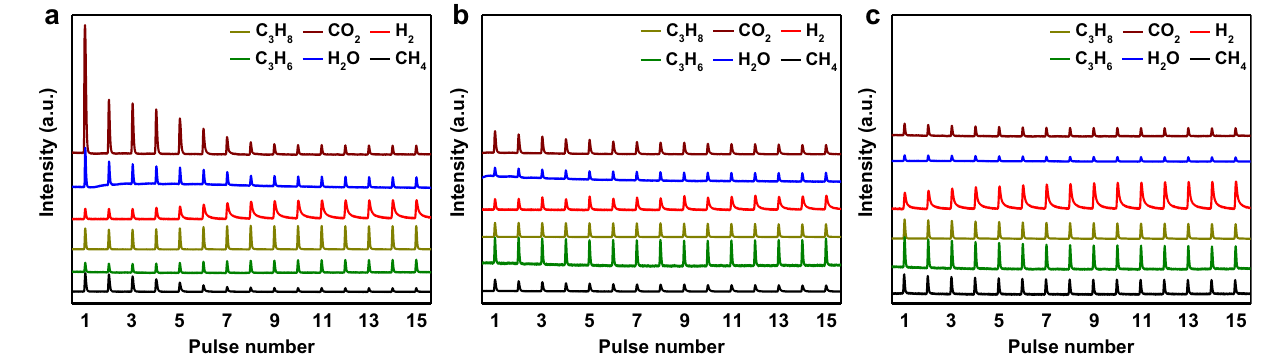
Fig.6|C 3 H 8 pulsesoverMoO 3 -Fe 2 O 3 redoxcatalysts. MassspectraduringC 3 H 8 pulsesover a FeAl, b 1Mo9FeAl,and c MoAl;0.5mLofC 3 H 8 wasinjectedintothereactor for each pulse at 570°C. The a.u. stands for arbitrary